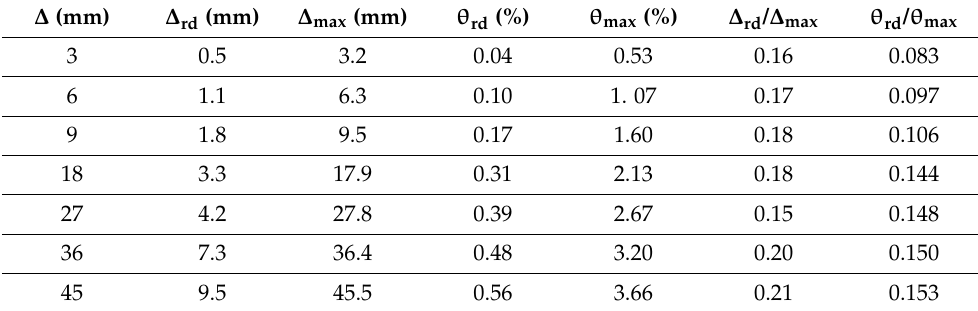
Table 4. Residual displacement and rotation in the HPC connection.